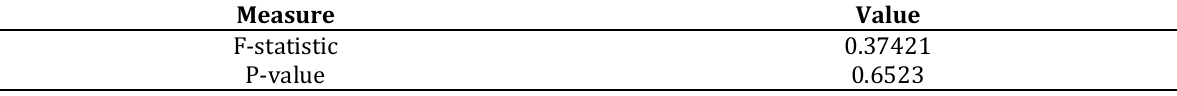
Table 26: Breusch-Godfrey Serial Correlation LM Test